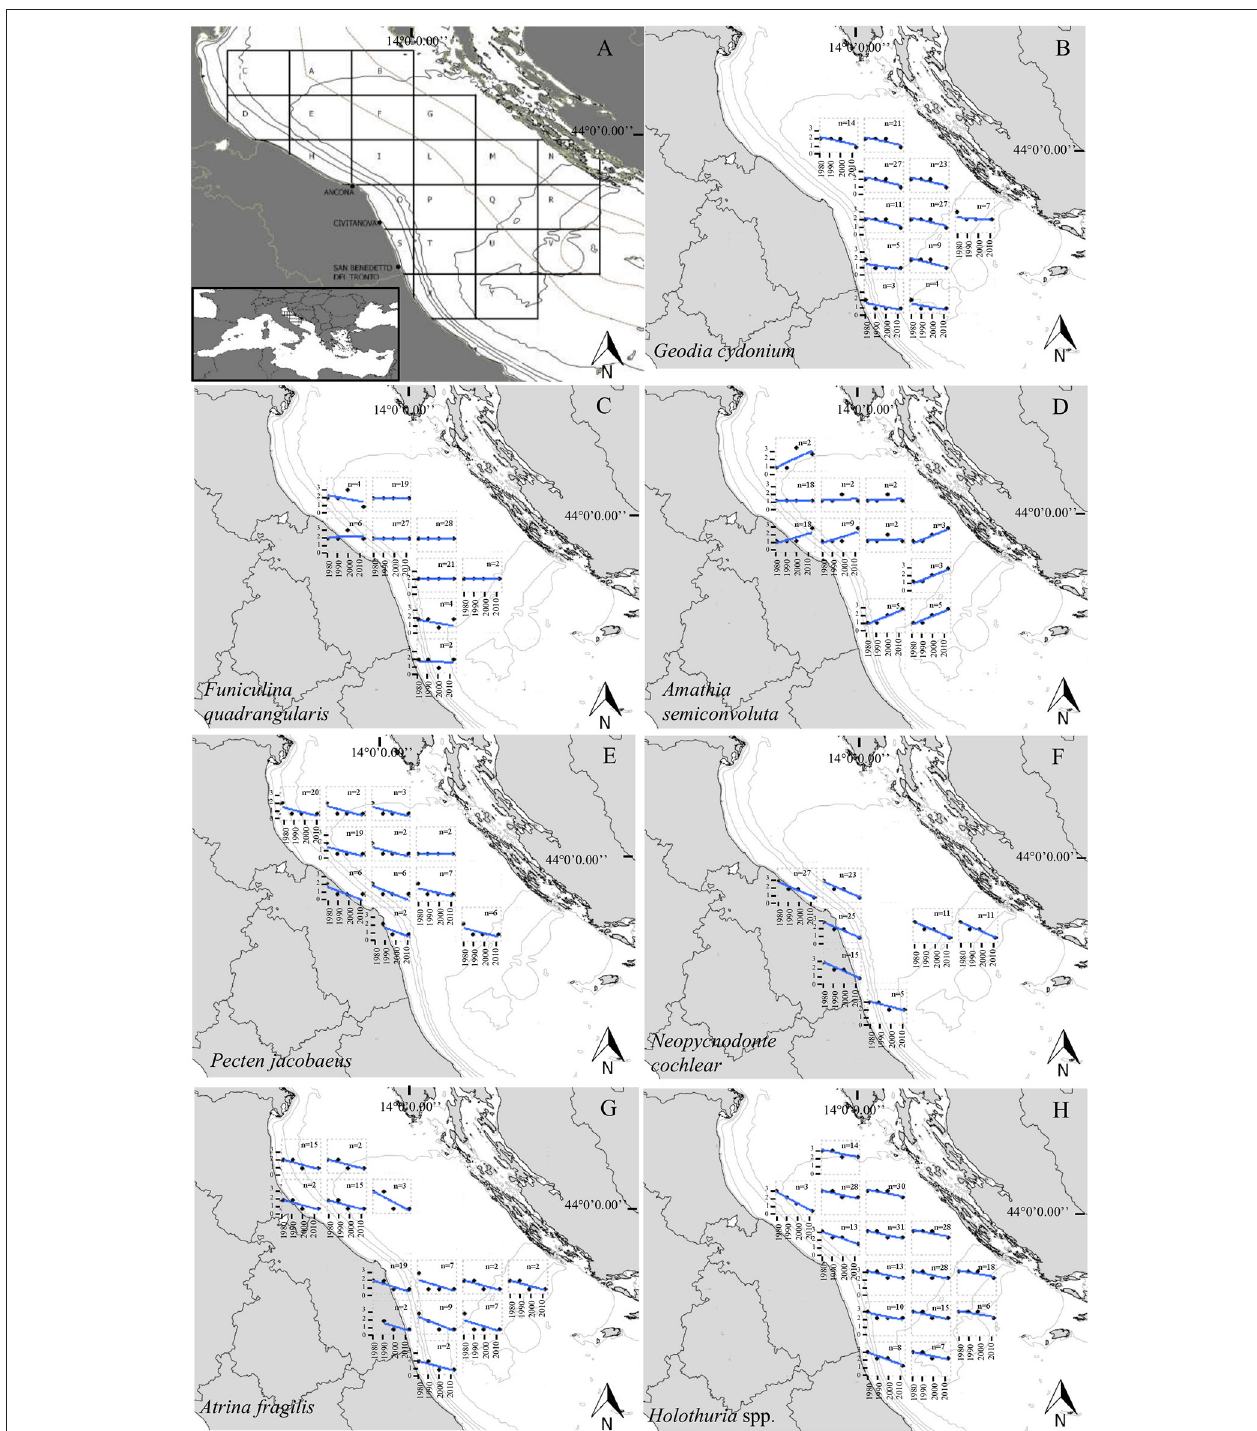
FIGURE 1 | Maps showing the geographical location and ports where fishers were interviewed (Ancona; Civitanova Marche; San Benedetto del Tronto) and trends of the taxa or species analyzed in our study. (A) Grid used to stratify the focal area. Letters are sector codes used to collect information about fishing locations during interviews. Gray lines identify areas outside Italian and Croatian territorial seas; black lines show the bathymetry. (B) Trends in the abundance of the sponge Geodia cydonium ; (C) Trends in the abundance of the sea-pen Funiculina quadrangularis ; (D) Trends in the abundance of the bryozoan Amathia semiconvoluta ; (E) Trends in the abundance of the scallop Pecten jacobaeus ; (F) Trends in the abundance of the fan mussel Atrina fragilis ; (G) Trends in the